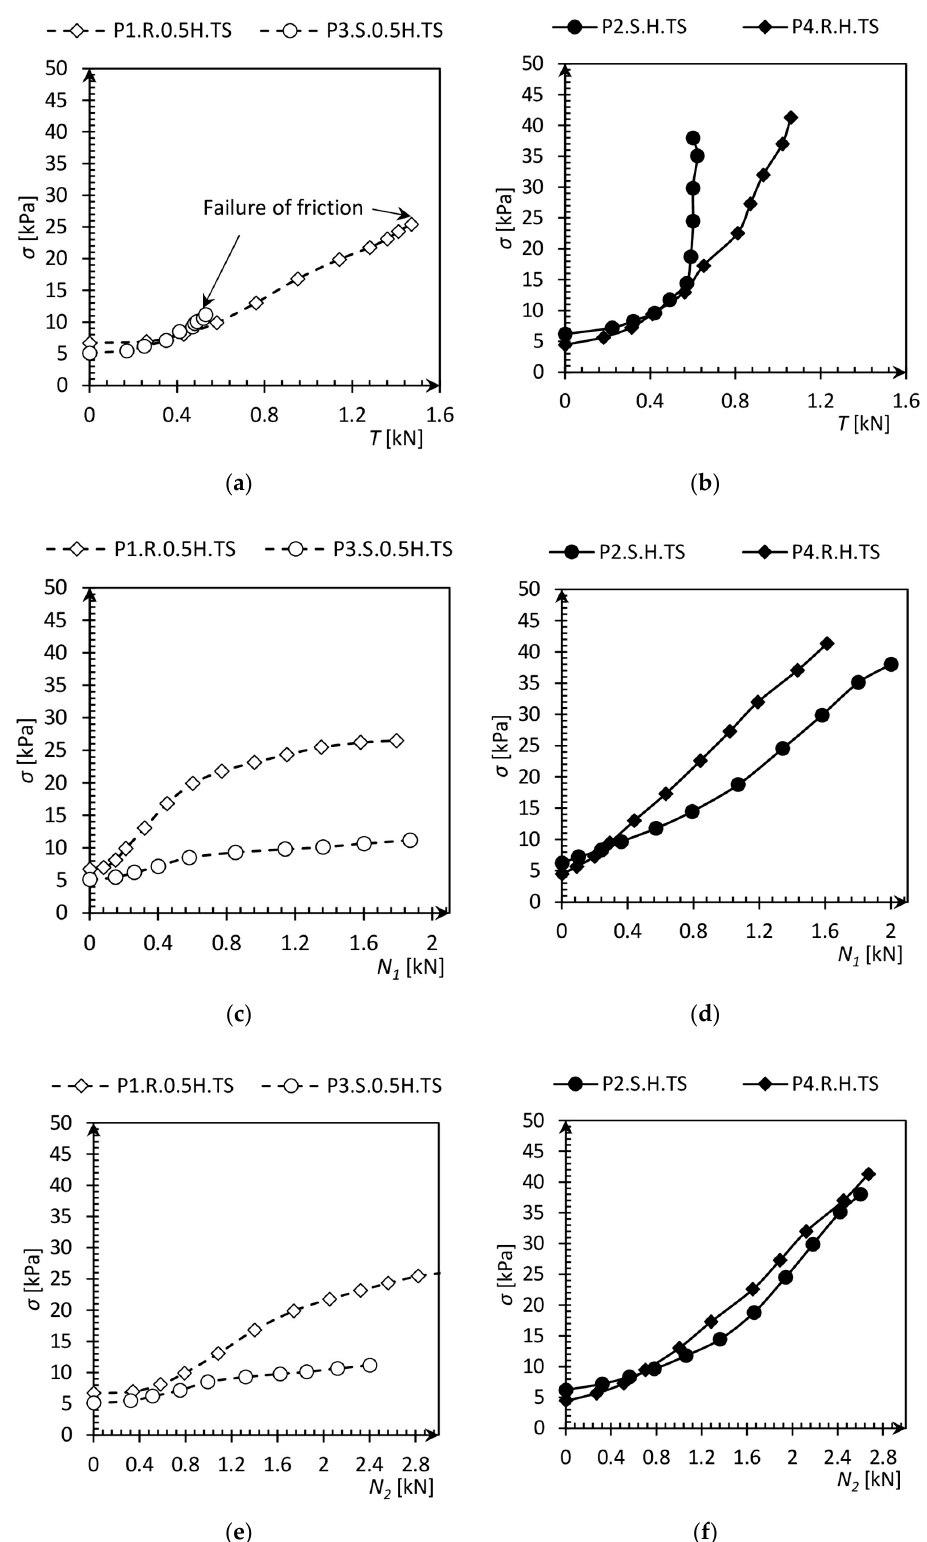
Figure 18. Pressure changes due to the skin friction T , base resistance N 1 , or applied load N 2 . Dashed lines mean pressure at the half of pile length level, solid lines mean pressure at pile base level. ( a , b ) Vertical stress versus skin friction. ( c , d ) Vertical stress versus skin friction. ( e , f ) Vertical stress versus applied